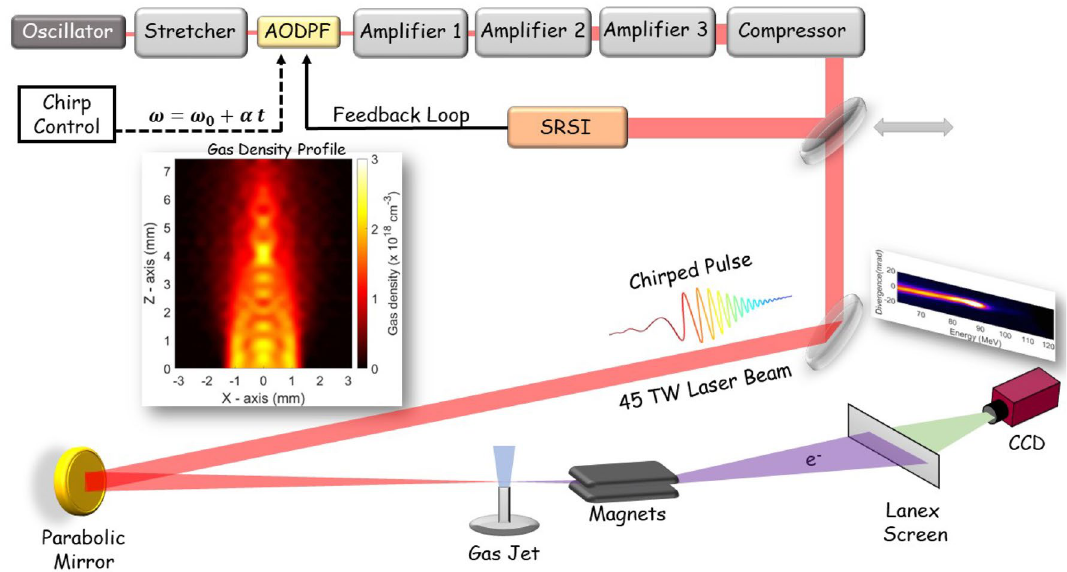
Figure 1. Schematic layout for the generation of MeV electron beams using chirped laser pulses delivered by the “Zeus” 45 TW laser system. The accurate control of the chirp value of the laser pulses is achieved by an acousto-optic dispersive programmable filter (AODPF), located prior to the three amplification stages. The laser pulse duration is measured after the final compression by a self-referenced spectral interferometry (SRSI) autocorrelator, which operates in feedback with the AODPF, to deliver the optimum temporal pulse shape. The laser beam is driven to the interaction chamber, where it is focused onto a pulsed He gas jet by an f /18 parabolic mirror. The resulting accelerated electrons are energy analysed by a uniform magnetic field, formed by two parallel-plate magnets, and driven onto a scintillating screen (Lanex Regular). Their spectrum is finally